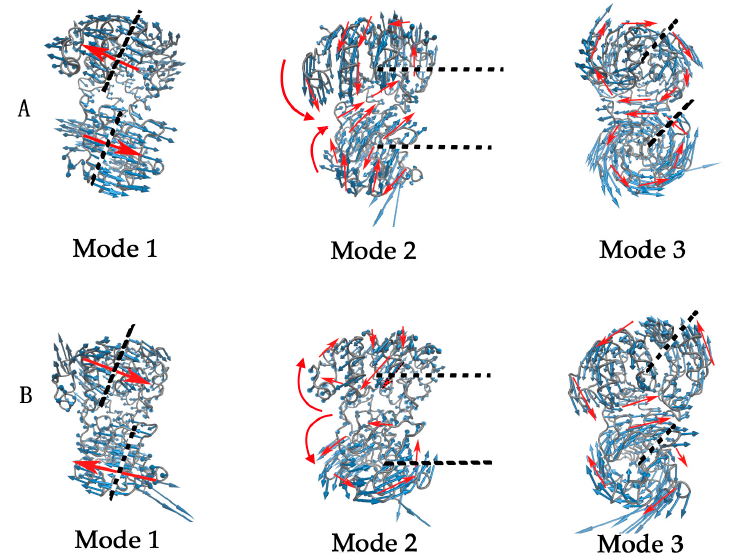
Figure 4. The first three slowest motion modes for the open-apo ( A ) and closed-holo ( B ) structure of L - Mt AlaDH. These figures were generated by visual molecular dynamics (VMD) [26]. In this figure, the protein structures are displayed in gray tubes. The amplitude and direction of the motions are represented by the length and direction of the blue arrows, respectively. The red arrows and black dashed lines denote the motion direction and the motion axis, respectively.